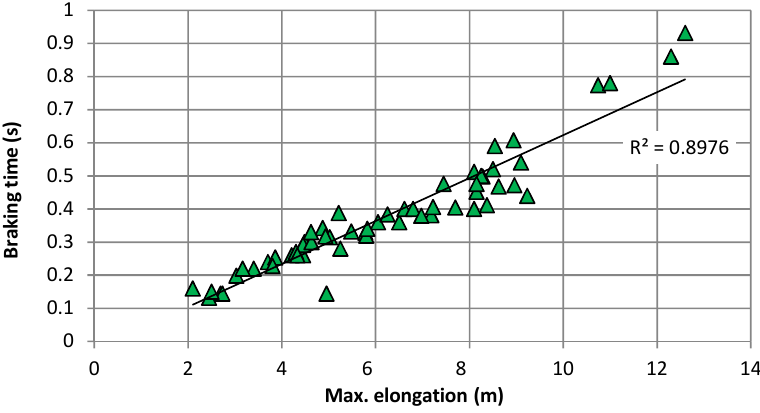
Figure 7. The relationship between braking time and braking distance is correlated by almost